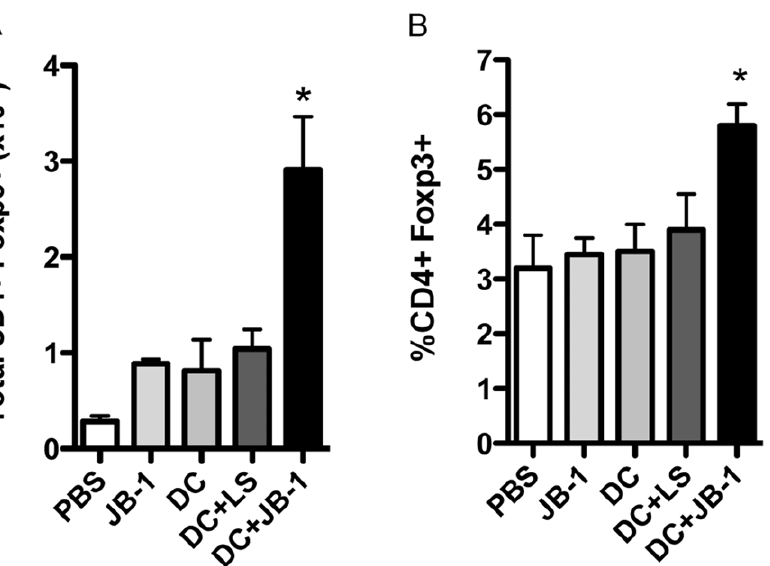
Figure 6. Dendritic cells exposed to JB-1 can induce Foxp3 expression in CD4 + T cells. Numbers (A) and percentage (B) of Foxp3 + CD4 + T cells in the popliteal lymph node of mice 5 days following adoptive transfer of JB-1 loaded BMDC into the footpad (1 6 10 6 cells). Transfer of unloaded BMDC served as a control. Data presented as mean 6 SEM, n=5, *p , 0.05.